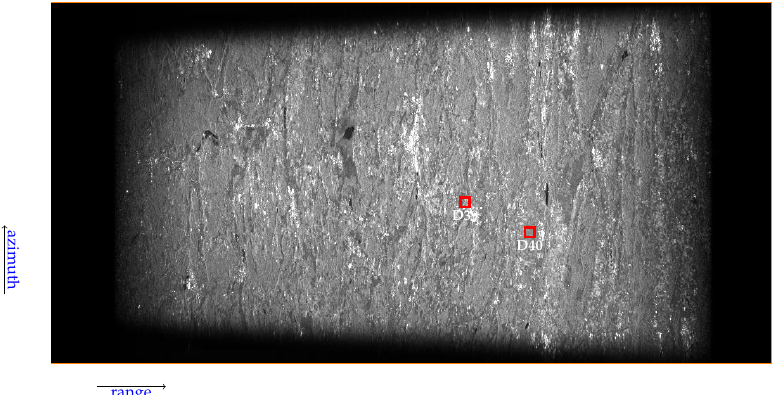
Figure 10. Focused image of burst 8 relevant to sub-swath 1: the position of two corner reflectors, referred to as D39 and D40 (see [50]), has been highlighted by the red squares.